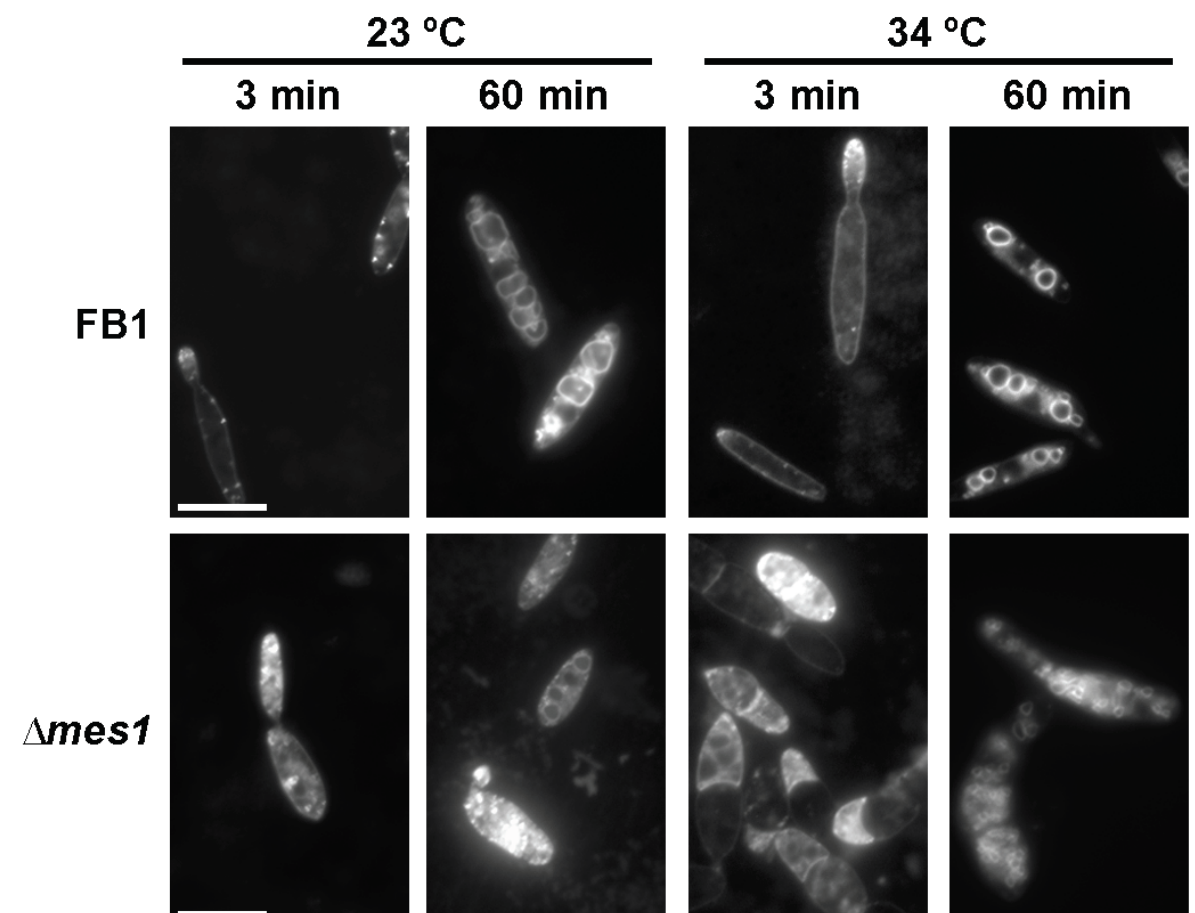
Figure 5. FM4-64 staining of vesicles in U. maydis ∆ mes1 . Cells were incubated at the indicated temperature for 4 h and then stained with FM4-64 dye for 3 or 60 min as indicated in the Materials and methods section. Cells were fixed and visualized under the fluorescent microscope. Bar size = 10 μ M.